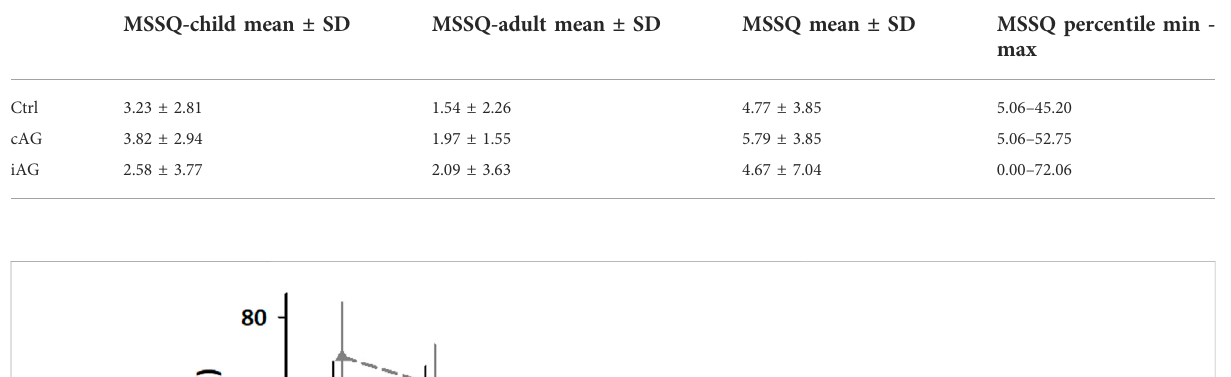
TABLE 7 Motion sickness susceptibility scores of the AGBRESA participants at BDC-10 per experimental group as evaluated using the MSSQ questionnaires.